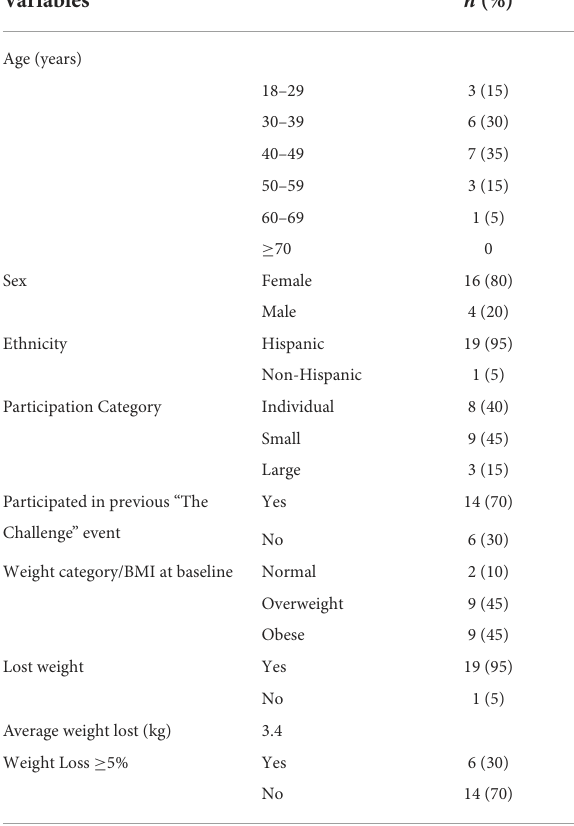
TABLE 1 Demographic characteristics of study participants ( N = 20).